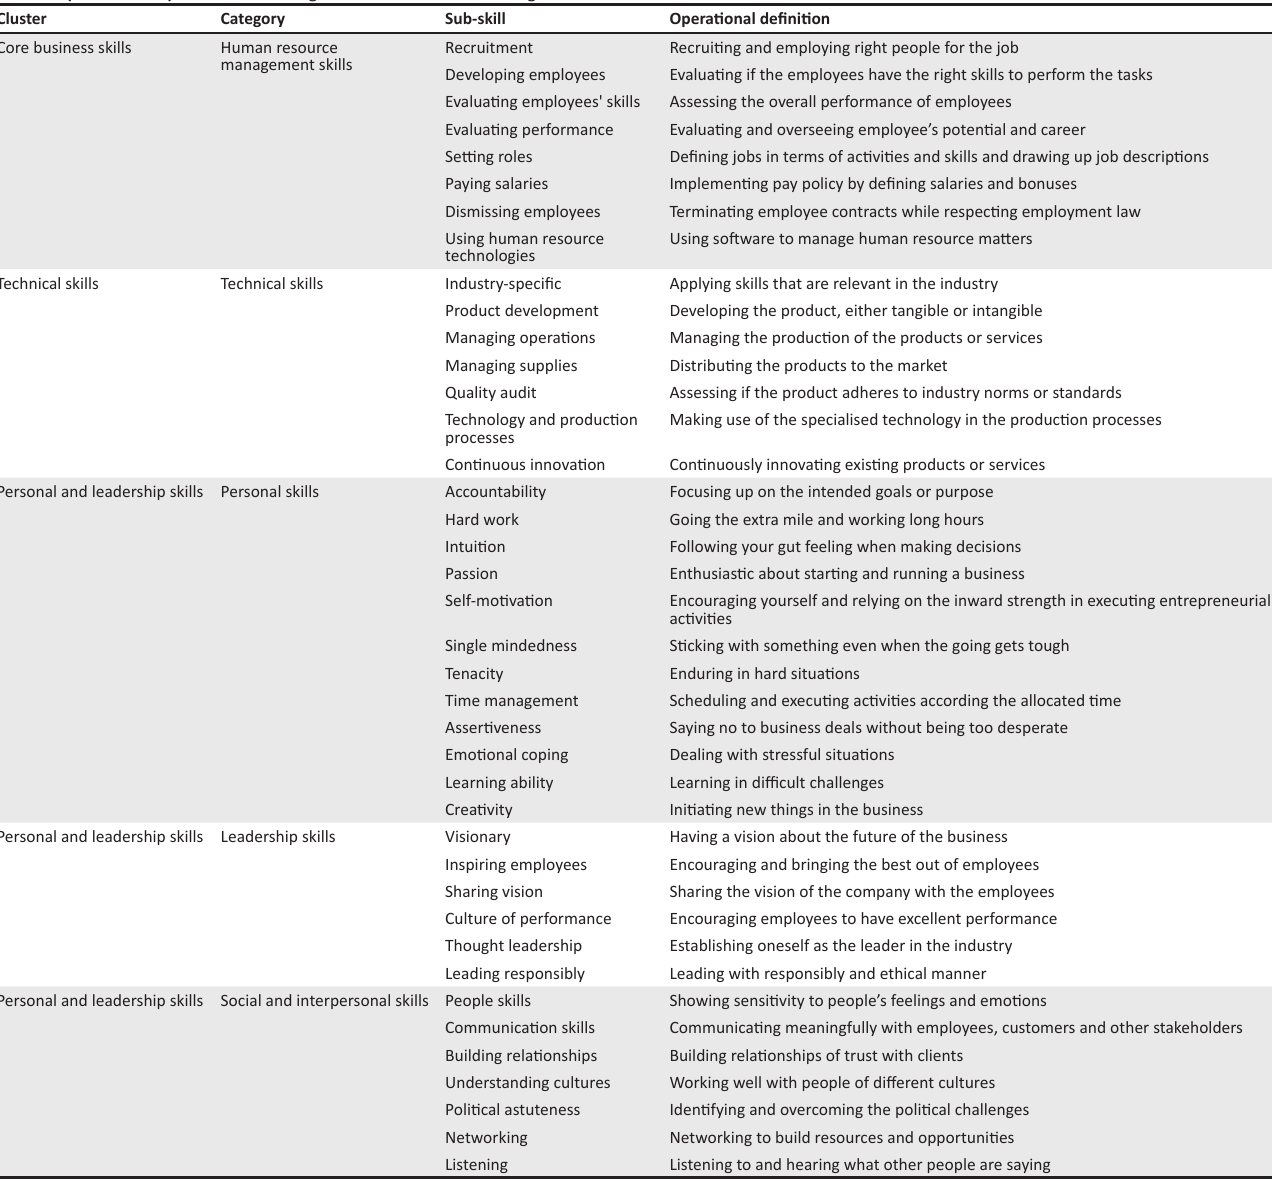
TABLE 3: (Continued...) Qualitative findings of skills and their sub-categories.